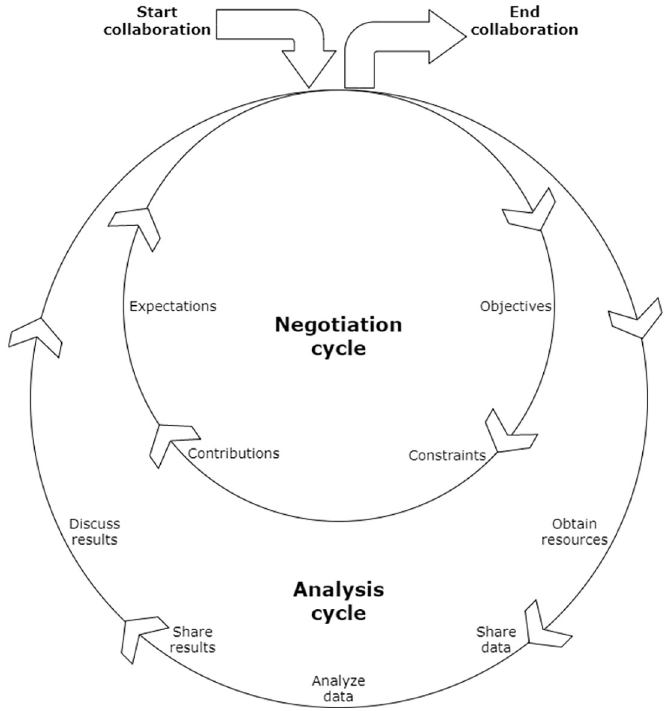
Fig 1. The collaboration process. The process of collaborative analysis of personal data can be modeled as a sequence of two cycles. In the negotiation cycle, the collaborators agree on the terms of the collaboration; in the analysis cycle, they pursue the objective defined in the analysis